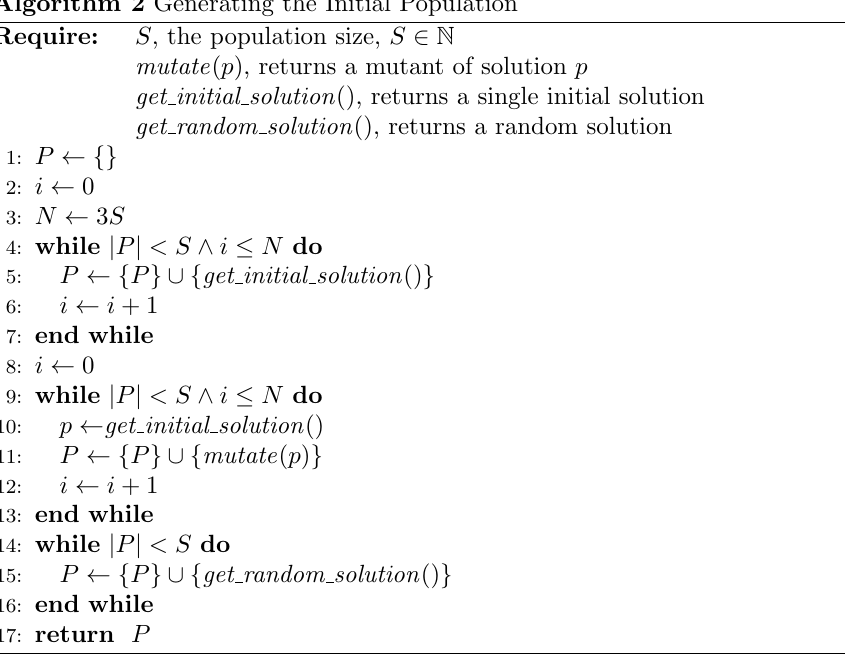
Algorithm 2 Generating the Initial